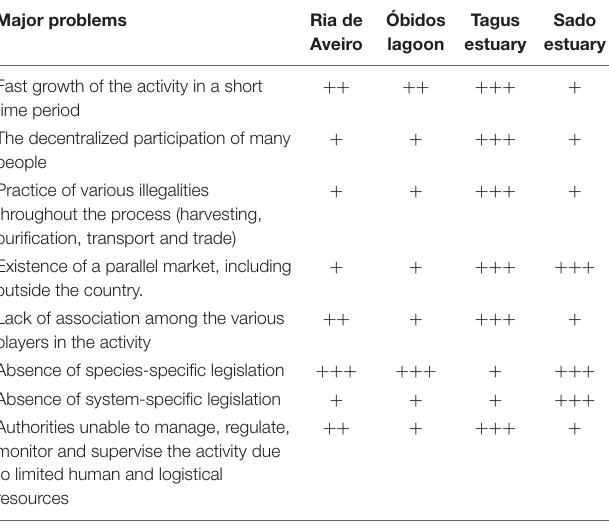
TABLE 2 | Summary and classification of major problems identified in the harvesting of Manila clam in Ria de Aveiro, Óbidos lagoon, Tagus estuary and Sado estuary.